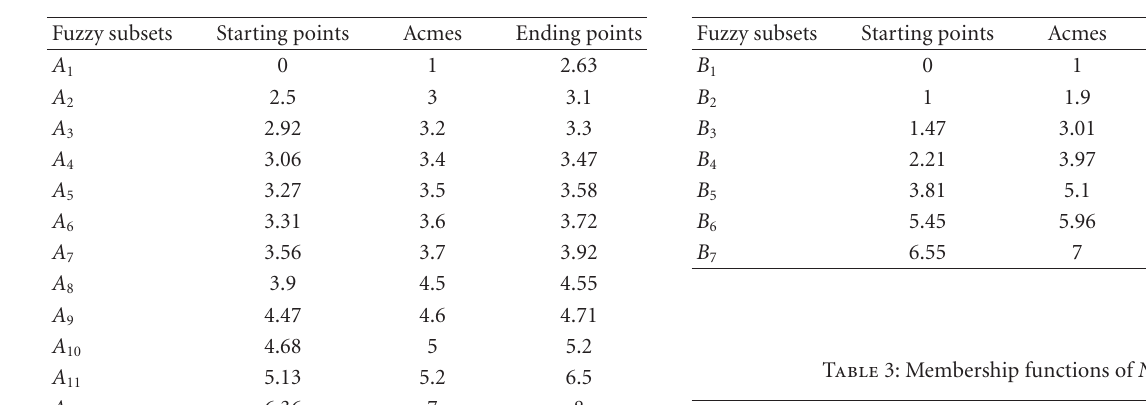
Table 1: Membership functions of F . Table 2: Membership functions of U .